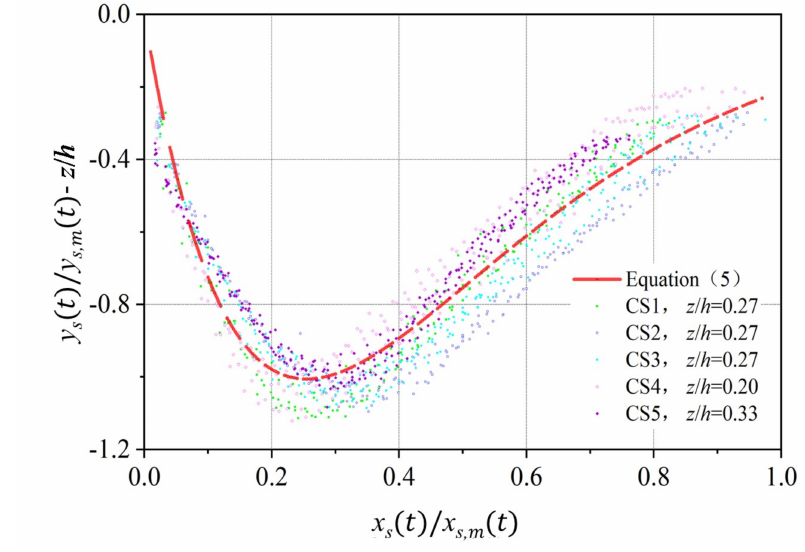
Figure 5. Temporal evolution of dimensionless scour profiles for t > 20